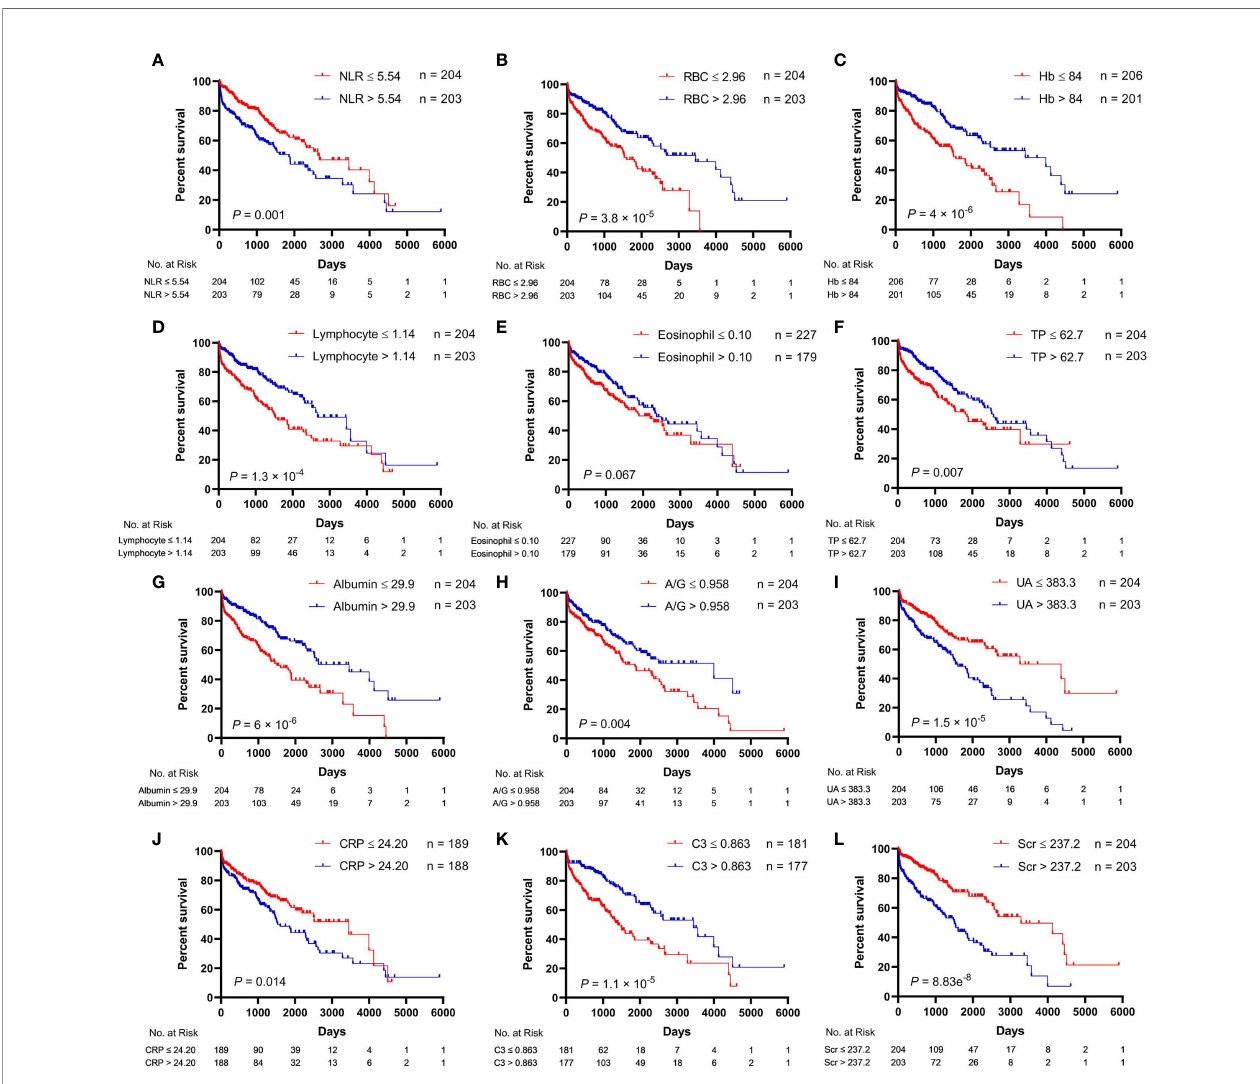
FIGURE 2 | Relationships between hematological parameters and overall survival in patients with antineutrophil cytoplasmic antibody (ANCA)-associated vasculitis. (A) NLR, neutrophil-to-lymphocyte ratio. (B) RBC, red blood cell. (C) Hb, hemoglobin. (D) Lymphocyte. (E) Eosinophil. (F) TP, total protein. (G) Albumin. (H) A/G, albumin-to-globulin ratio. (I) UA, uric acid. (J) CRP, C-reactive protein. (K) C3, complement 3. (L) Scr, serum